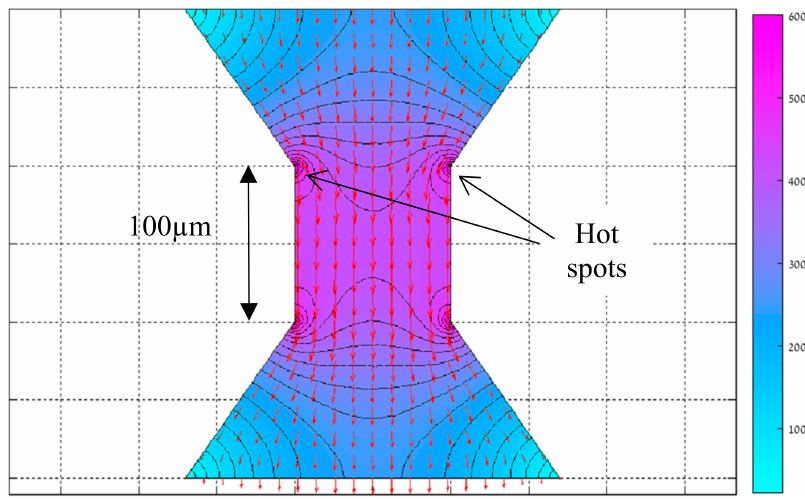
Figure 2. Electric field simulation of Trapezoid resistor.